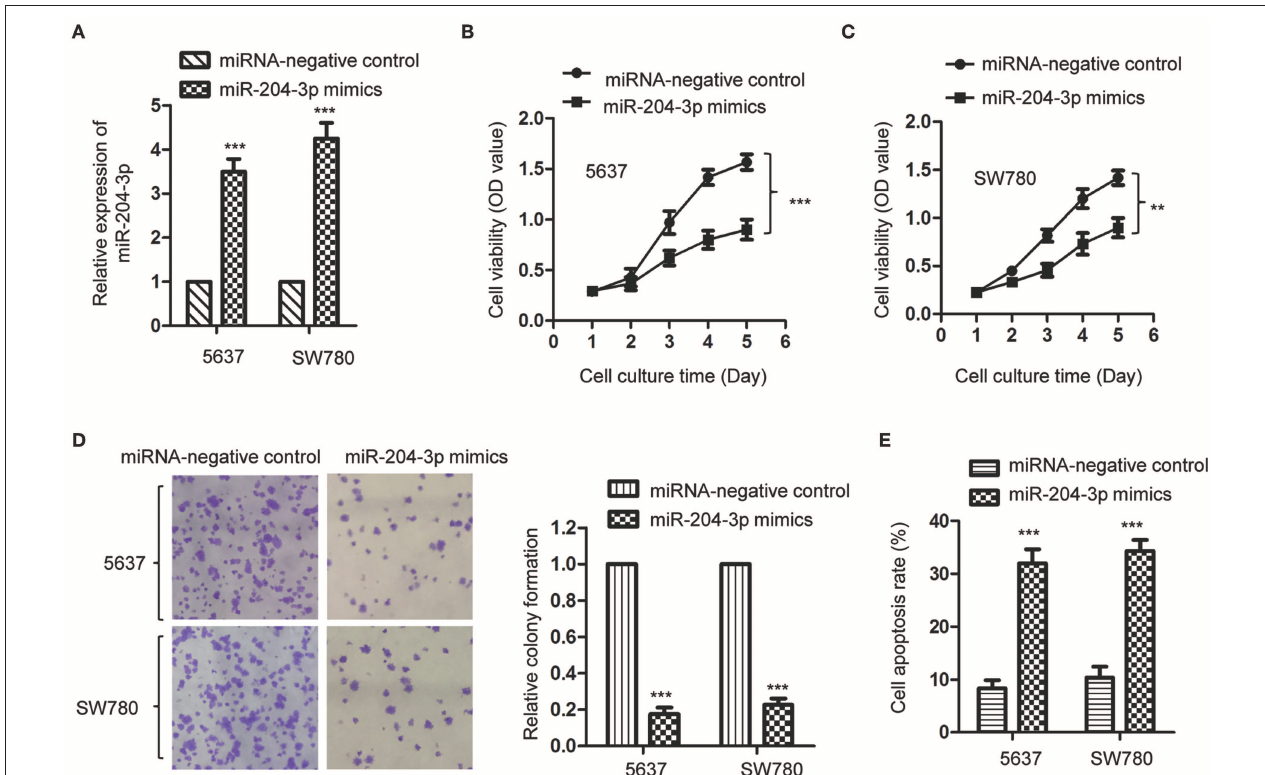
FIGURE 2 | Overexpression of miR-204-3p inhibited the proliferation of bladder cancer cells. (A) The expression of miR-204-3p in both SW780 and 5637 cells with the transfection of miR-204-3p mimics or control miRNA was validated by RT-qPCR. (B,C) The proliferation of cells with miR-204-3p mimics or control miRNA transfection was determined by CCK-8 assay. (D) Colony formation assay was performed in both SW780 and 5637 cells with the transfection of miR-204-3p mimics or control miRNA. (E) Flow cytometry was performed in both SW780 and 5637 cells with the transfection of miR-204-3p or control miRNA. N = 3; ** P < 0.01 and *** P < 0.001. RT-qPCR, reverse transcriptase quantitative PCR; CCK-8, Cell Counting